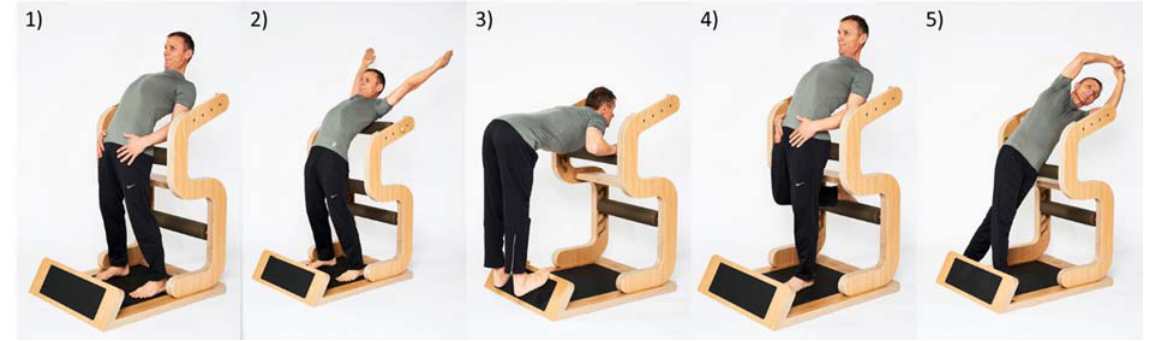
Figure 2. All five exercises of the “five-Business” workplace health promotion program. Exercises in the order of execution: (1) Stand, (2) Chest, (3) Ischio, (4) Hip and (5) Lateral.